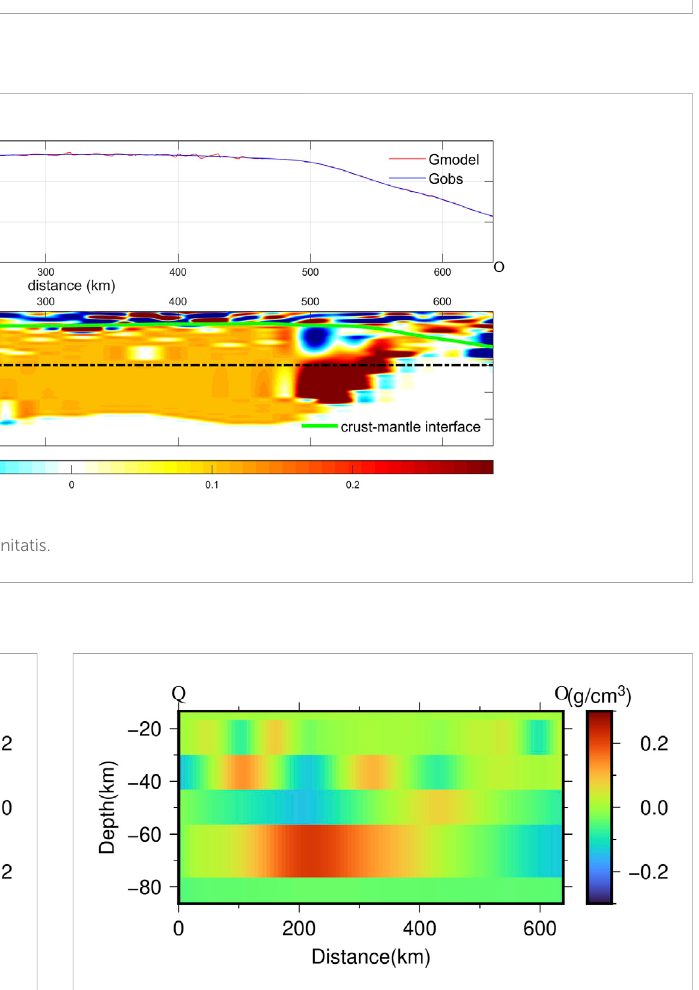
FIGURE 12 Pro fi le density of E-F from the layered density inversion in Figure 5.